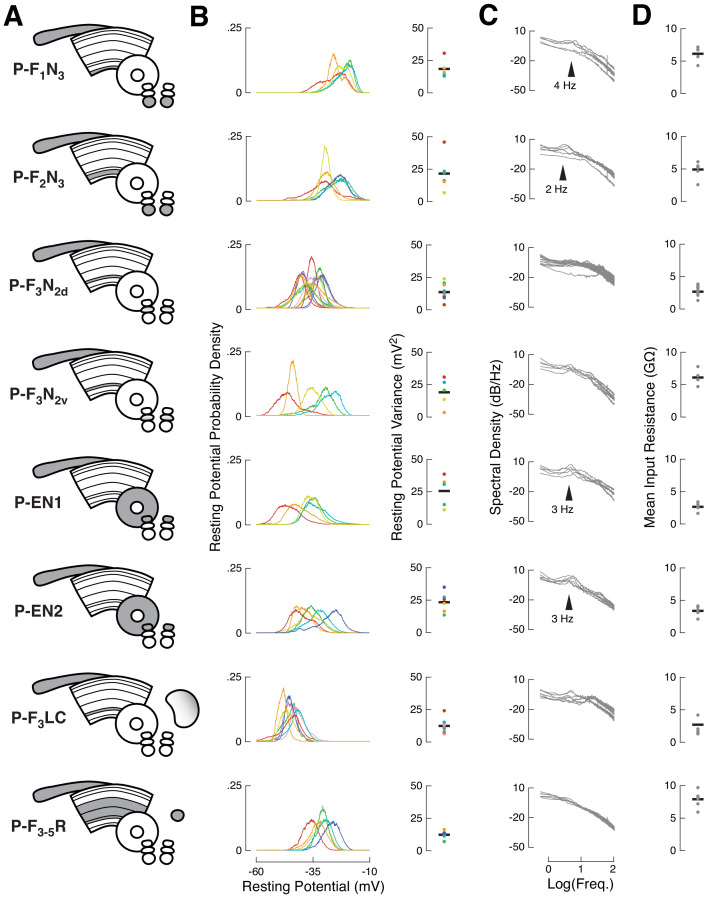
Baseline activity characterization for recorded cell types.(A) CX neuropils innervated by each recorded cell type. Each cell type is named after standard nomenclature: single letters represent innervated neuropil (gray), with putative input regions before the dash, and putative output or mixed process regions after the dash. Each recorded neuron was filled with biocytin to confirm its identity. Previous work identified two anatomically identical but functionally distinct classes of P-ENs. PB, protocerebral bridge; FB, fan-shaped body; EB, ellipsoid body; NO, noduli; ROB, round body; LAL, lateral accessory lobe. Each row in panels (B–D) contains data from the cell type shown. (B) Left: resting membrane potential distributions for each neuron (colored lines) from the indicated cell type. Ventral P-FNs (P-F1N3 and P-F2N3) rested high (−25 mV), P-F3LC rested low (−50 mV), and all other cell types rested near −35 mV. Right: resting membrane potential variance for each neuron (colored dots) from each cell type. Black bars indicate cross-cell means. P-ENs and some P-FNs showed the greatest potential variance at rest, due to rhythmic/bursty baseline activity (see C). (C) Spectral density of the raw voltage signal for each neuron (gray lines) from the indicated cell type. Note that the x-axis is plotted on a log scale. Noteworthy deviations from 1/F density are marked with arrowheads. Both types of P-EN showed strong rhythmic/burst activity with an interval of approximately 350 msec. Ventral P-FNs displayed less regular rhythmicity at different timescales. (D) Mean input resistance for each neuron (gray dots) from each cell type. Input resistance was sampled on each trial, so each point is the mean of 40–80 Rin measurements, depending on the number of trials completed for each neuron. Black bars indicate cross-cell means.